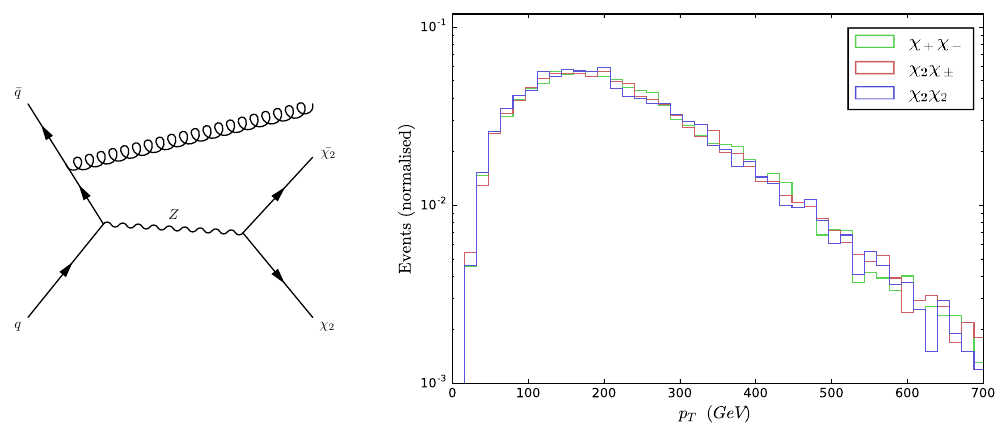
Figure 7 . Left: Feynman diagram for the process pp (cid:22) (cid:31) 2 (cid:31) 2 + j (blue), pp pp ! for m 2 m (cid:6) = 300 ’